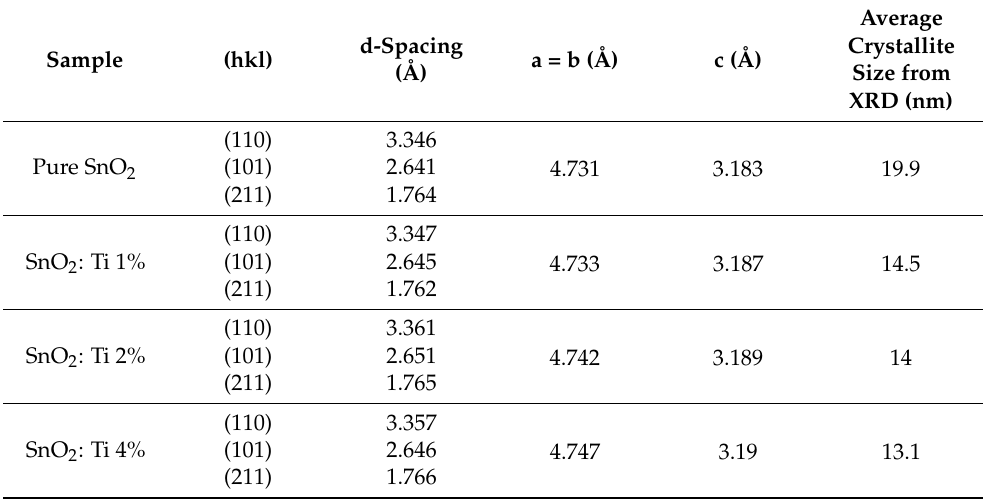
Table 1. Crystallographic data including lattice parameters (a, c) and the average crystallite size of Ti–SnO 2